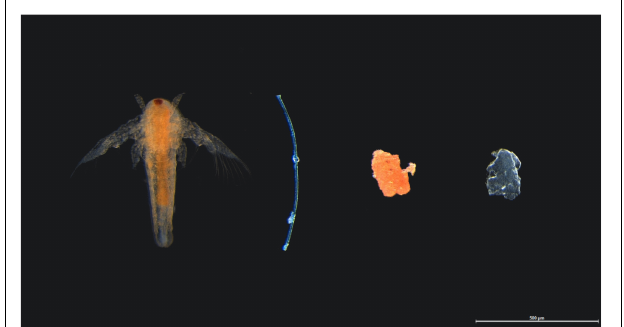
FIGURE 1 | Comparable shapes and sizes of food and experimental microplastics given to adult damselfish Pomacentrus amboinensis in a controlled laboratory experiment. Food included orange post-hatched artemia (far left) and orange food pellet (second right). Experimental microplastics included blue polyester fiber (2nd left) and blue polypropylene particle (far right), with photo taken before biofouling of microplastics.